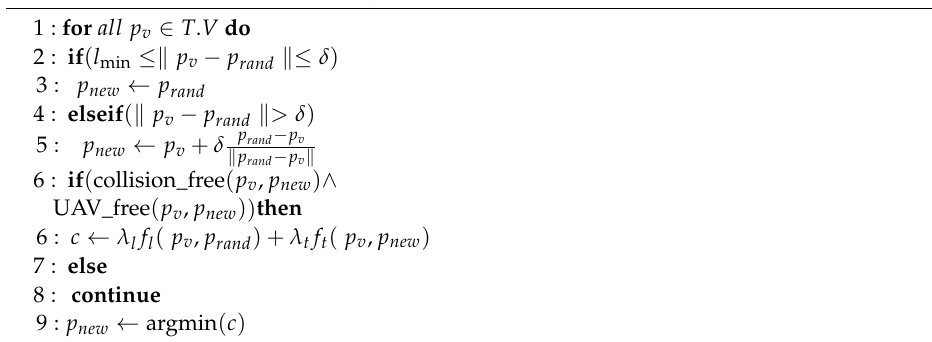
Figure 2. No. 1 shows the flight constraint determination (true or false symbol) and the flight cost f c for potential new nodes (orange nodes). No. 2 shows that the new node expansion of FC-RRT* has been completed. The black nodes and edges are the trees that have been generated, and the blue node is p rand . Algorithm 2: Heuristic_cost ( T . V , p rand )